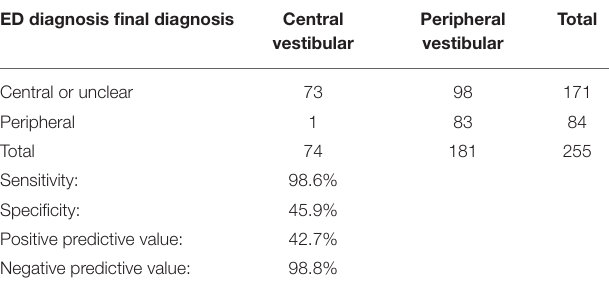
TABLE 4 | Accuracy of ED triage algorithm in vestibular